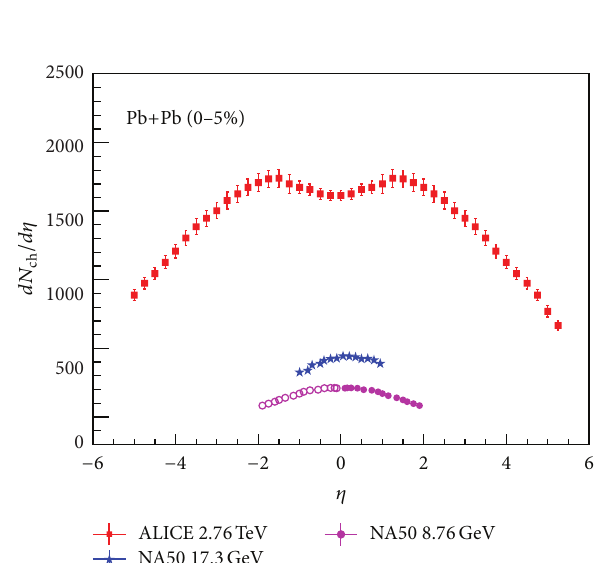
Figure 4: Charged particle pseudorapidity distributions of Pb+Pb collision systems for the most central events at different collision